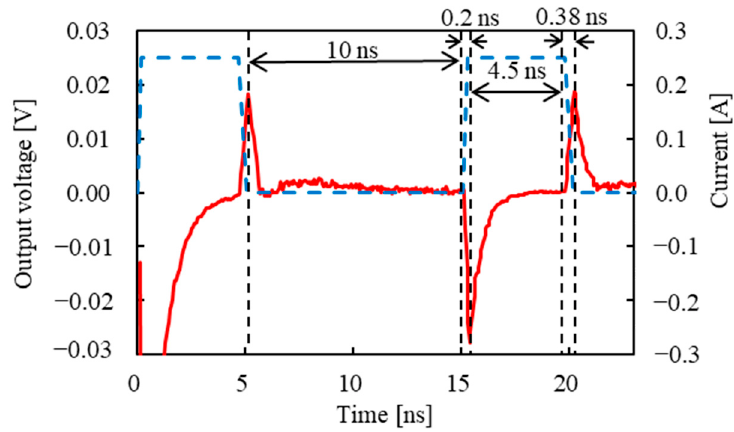
Figure 9. Pulse current waveform and an example output voltage.